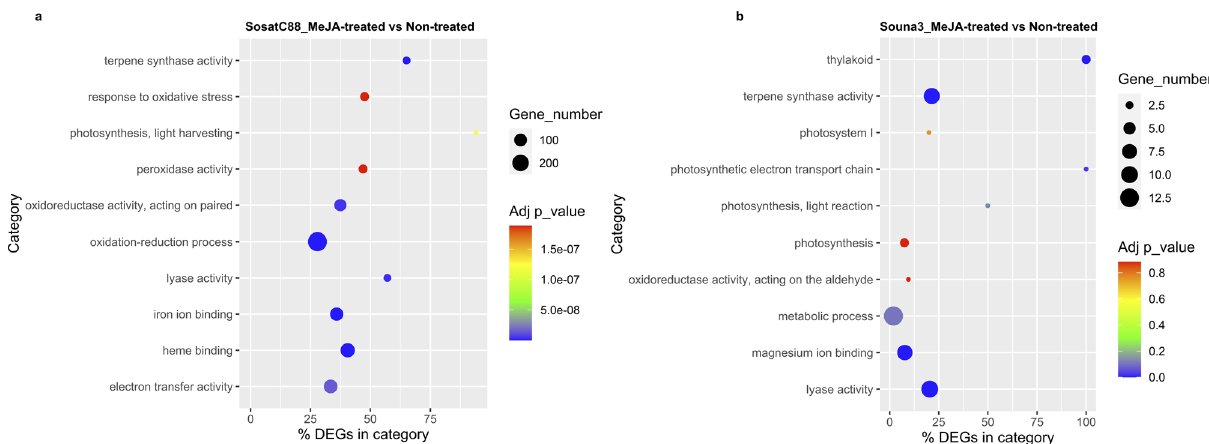
Figure 6. ( a ) The top 10 over-represented GO terms in SosatC88_MeJA-treated-vs-non-treated. ( b ) The top 10 over-represented GO terms in Souna3_MeJA-treated-vs-non-treated. The Adj p-value is the corrected p-value ranging from 0 to